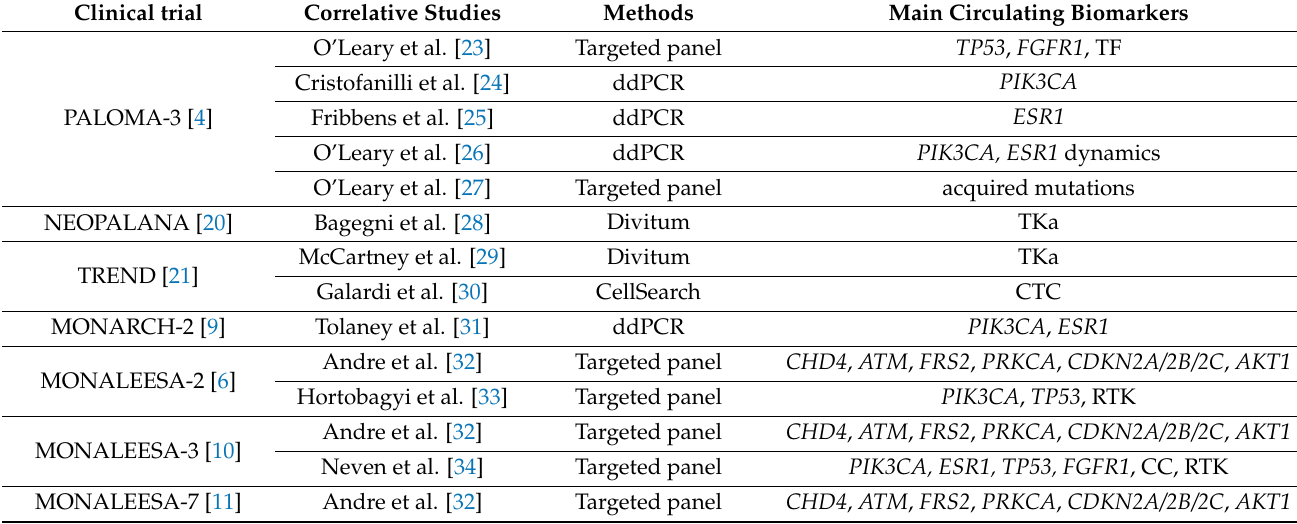
Table 2. Correlative studies on circulating biomarkers for main clinical trials on